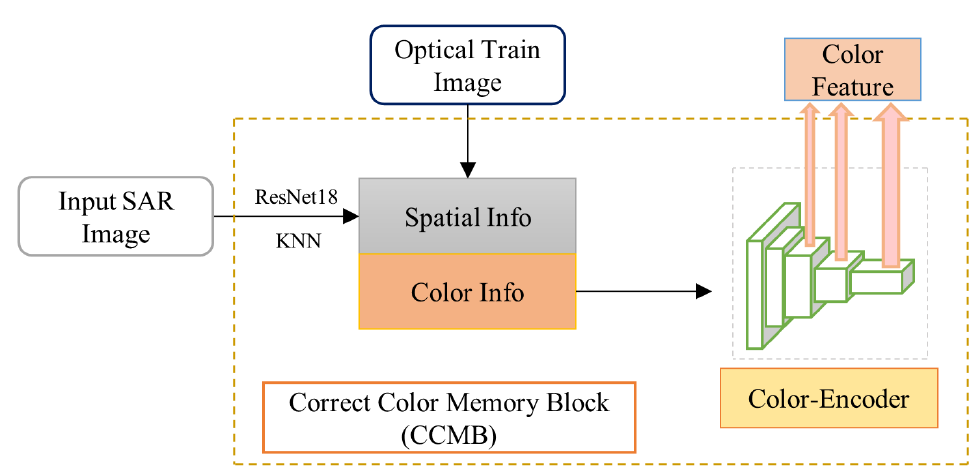
Figure 5. The architecture of CCMB. The spatial information of the input SAR image is calculated by the ResNet18 network, and the color information corresponding to the most similar spatial information in the optical training set image is returned by the KNN algorithm. The color information is input into the full convolutional encoder network, and the color features of different feature scales are cascaded with the decoder. Best viewed in